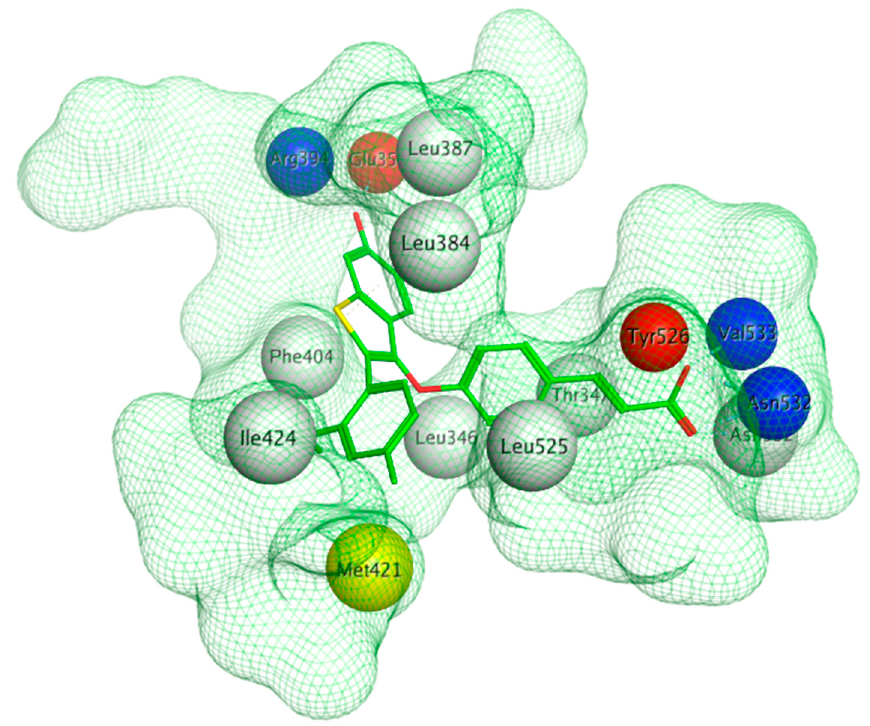
Figure 9. Site view of LSZ102 (green) in complex with ER α -EBS (pdb: 6B0F).